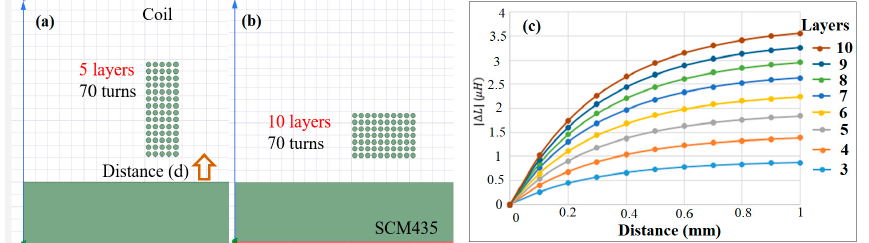
Figure 4. ( a ) Coil winding arrangement with 5 layers, ( b ) coil winding arrangement with 10 layers, and ( c ) effect of number of layers on inductance sensitivity.